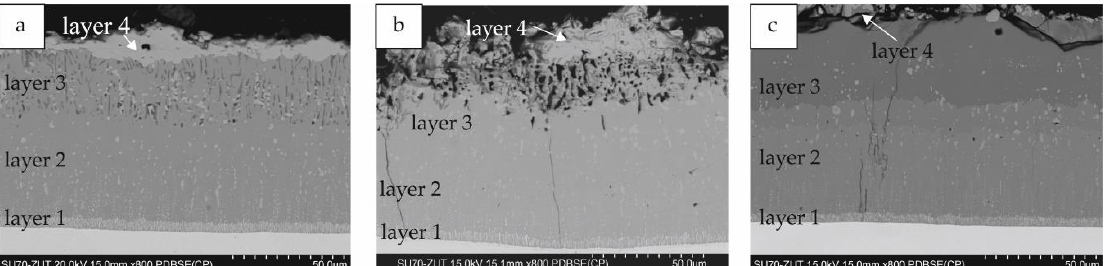
Figure 7. The microstructure (BEI) of Si-Al coatings obtained at 1000 °C for 4 h with the slurry volume of ( a ) 0.15; ( b ) 0.3; and ( c ) 0.6 g/cm 2 .